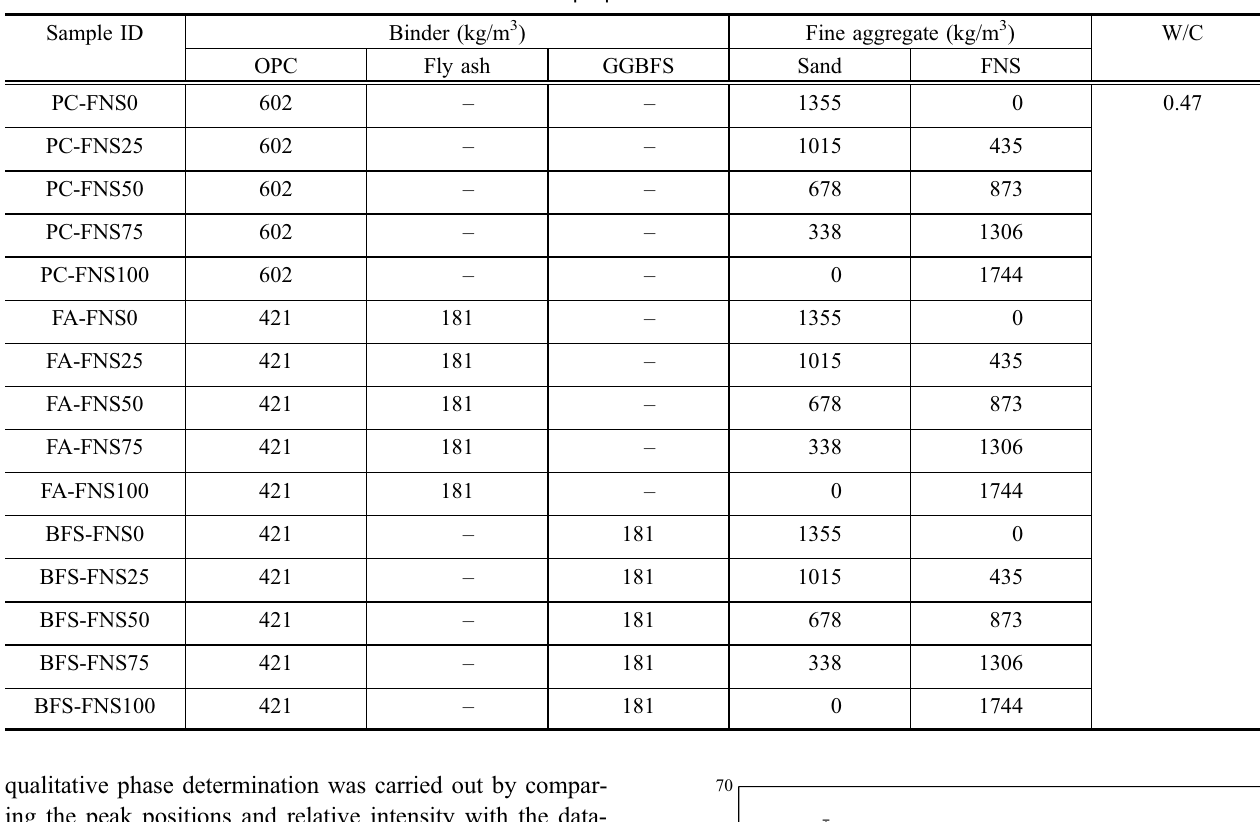
Table 4 Mix proportions of the mortars.